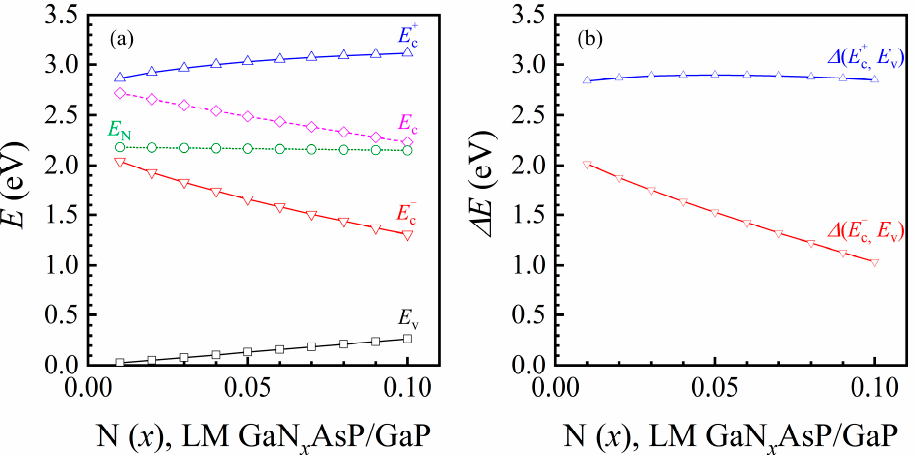
Figure 2. ( a ) Calculated E + c and E − c band edges of GaP-lattice-matched GaN x AsP y , as a function of N mole fraction. The reference energy level is the valence band edge of GaP. The valence band edge ( E v ), the conduction band edge ( E c ), and the nitrogen level ( E N ) of the related GaAsP y ; ( b ) Calculated GaP-lattice-matched GaN x AsP (LM GaN x AsP with GaP) energy gap ( ∆ E ) between E + c and valence band ( E v ), ∆ E ( E + c , E v ), and between E − c and E v , ∆ E ( E − c , E v ), as a function of N mole